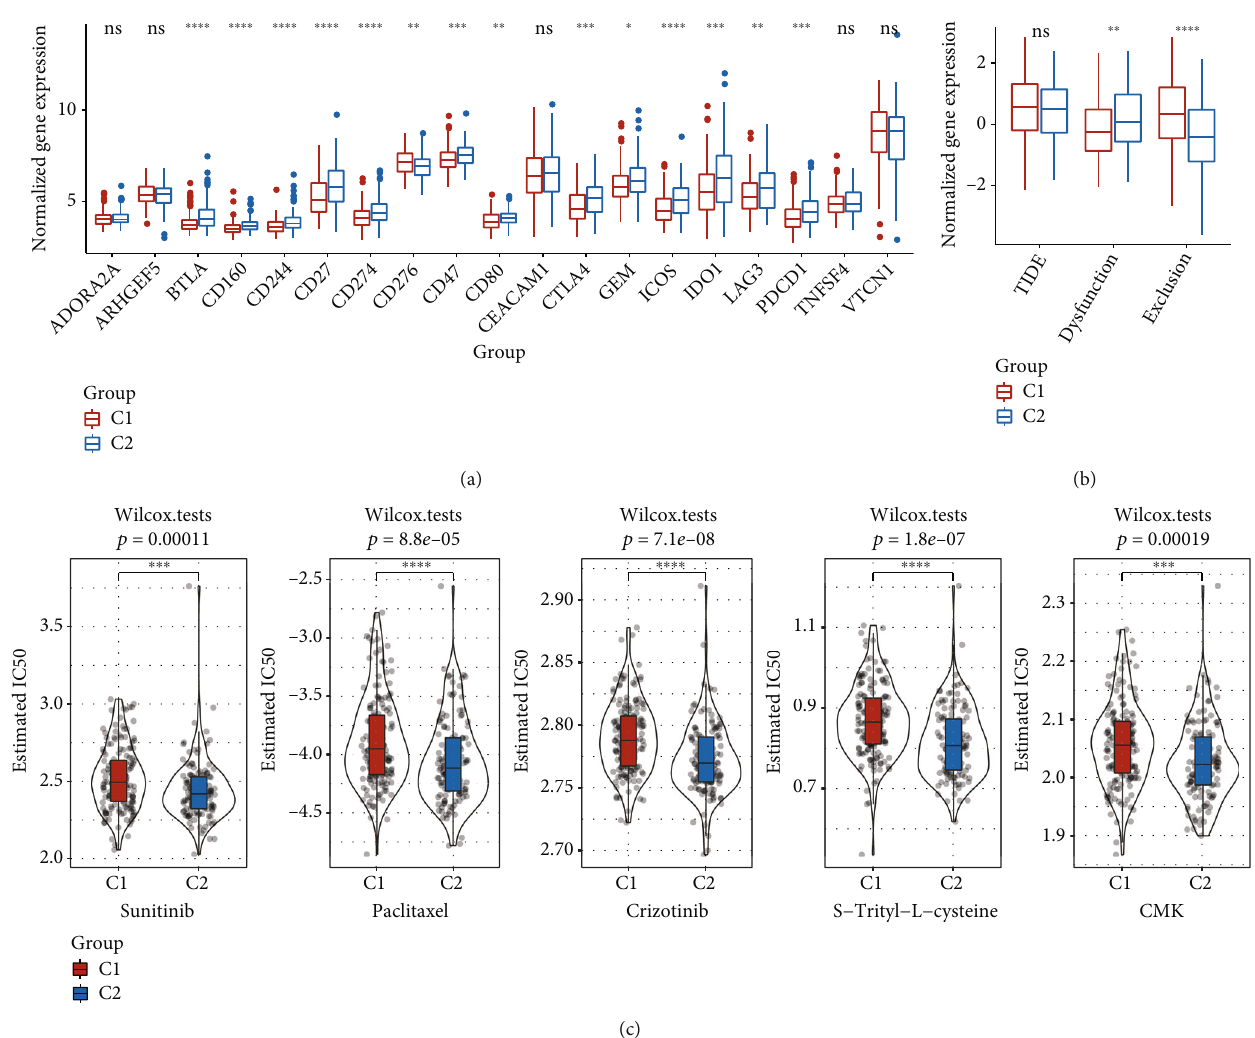
Figure 3: Immunotherapy/chemotherapy di ff erence between the two subtypes in the RNAseq data set. (a) Immune checkpoints present di ff erential expression between the various groups in the RNAseq data set. (b) The TIDE analysis di ff erence between di ff erent groups in the RNAseq queue. (c) The box plots constructed using the calculated IC50 for sunitinib, paclitaxel, crizotinib, and bexarotene in